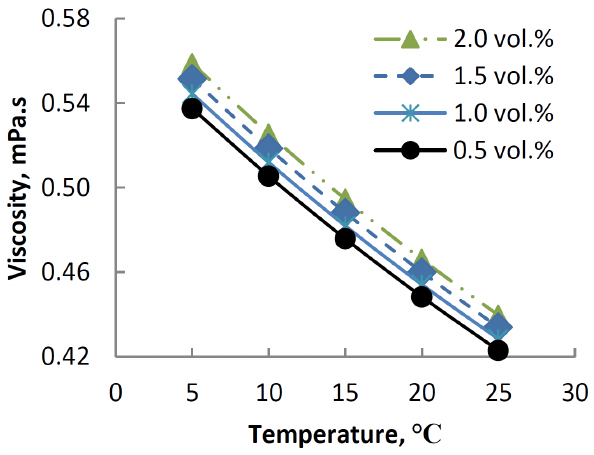
Figure 6. Effect of temperature on viscosity of nanorefrigerants [26].